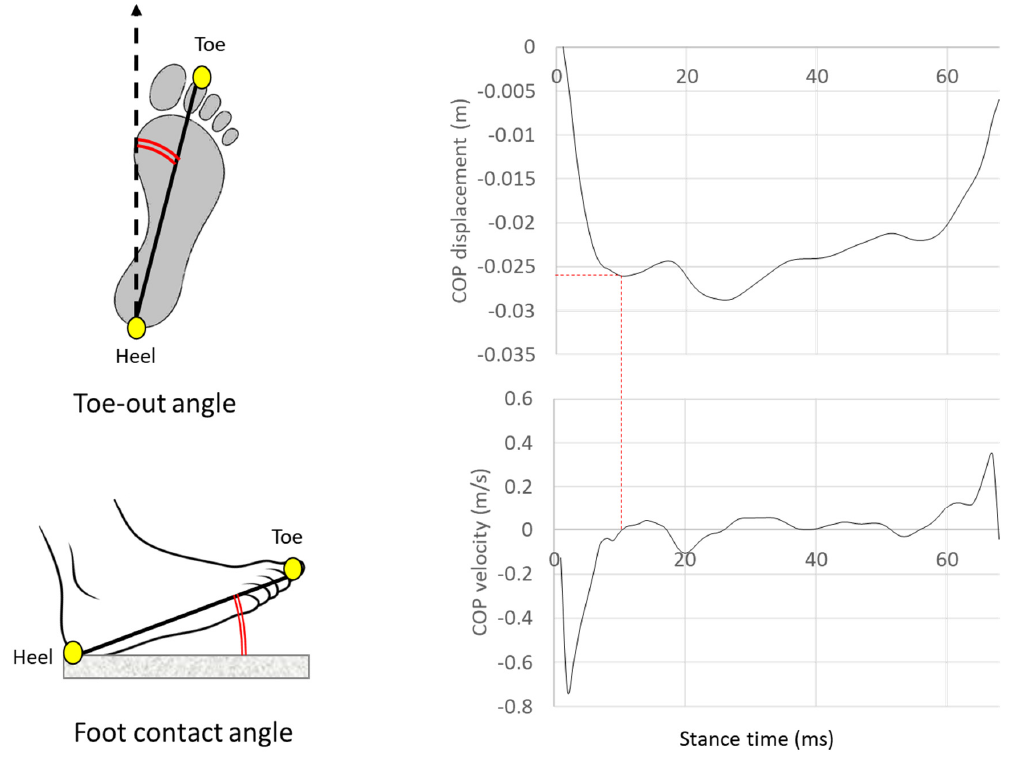
Figure 2. Toe-out angle, foot contact angle, lateral centre of pressure (COP) displacement.